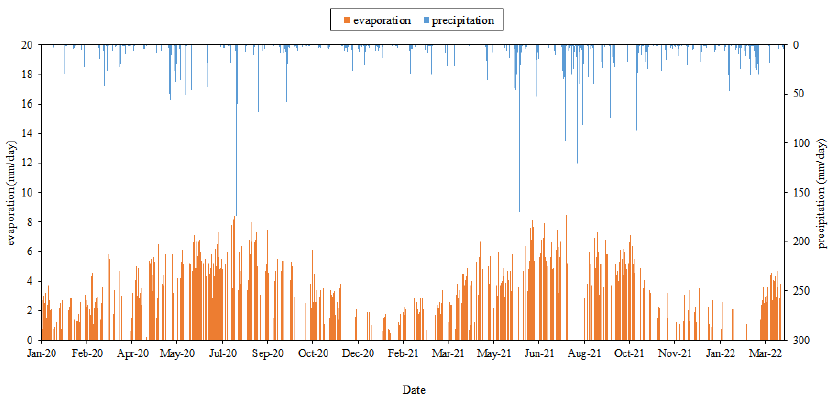
Figure 3. The studied raingarden site. ( A ) Site photo and ( B ) sketch of the site area. The monitoring periods for the two sites were different. The permeable pavement